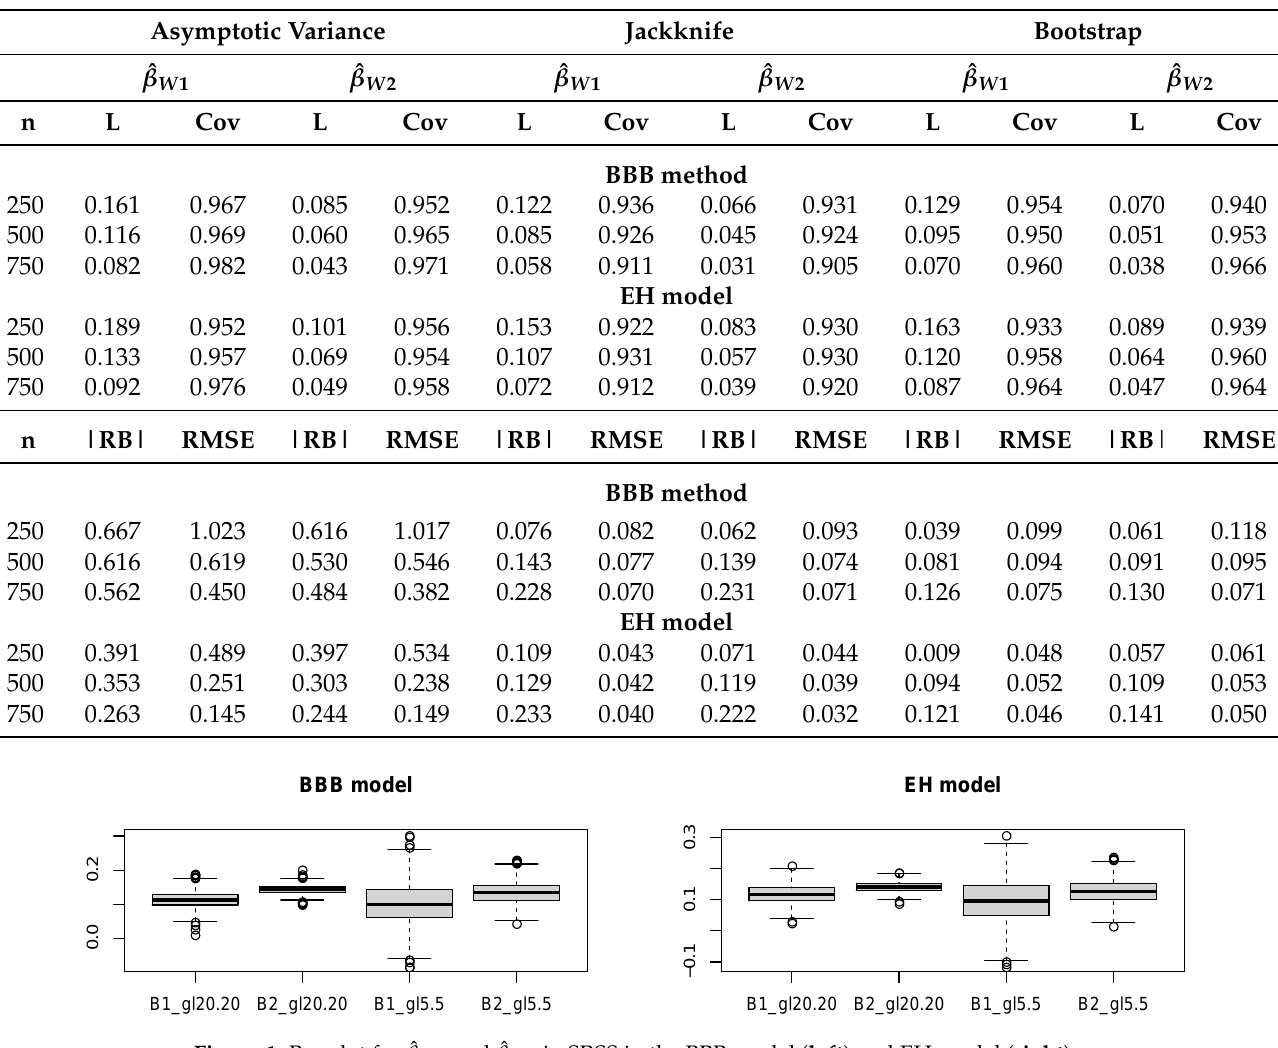
Table 2. Average length and coverage, relative bias and relative mean squared error for AV, JK and BS variances of ˆ β W 1 and ˆ β W 2 in SRSS for the BBB and EH models.